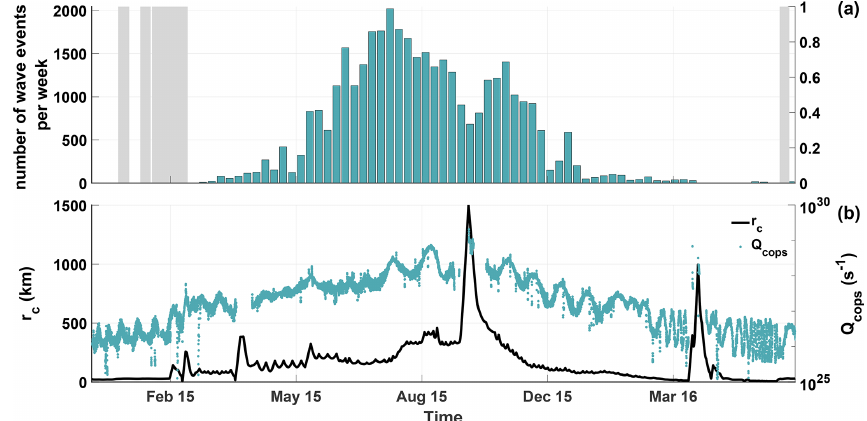
Figure 2. Panel (a) depicts the number of observed steepened waves per week over the course of the mission. The gray areas mark the periods in which no magnetic field measurements were available. In (b) the water outgassing rate ( Q ) and the cometocentric distance ( r c ) are shown. The outgassing rate was computed using the Haser model (Haser, 1957) and local ROSINA-COPS measurements. A constant neutral gas velocity of 800ms − 1 was assumed. The neutral gas density measurements are noncontinuous, with occasional data